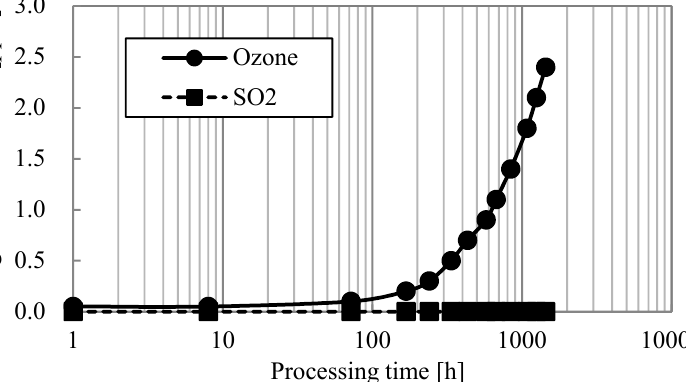
Figure 11. The time variations of outlet ozone and SO 2 concentration of impregnated activated car-